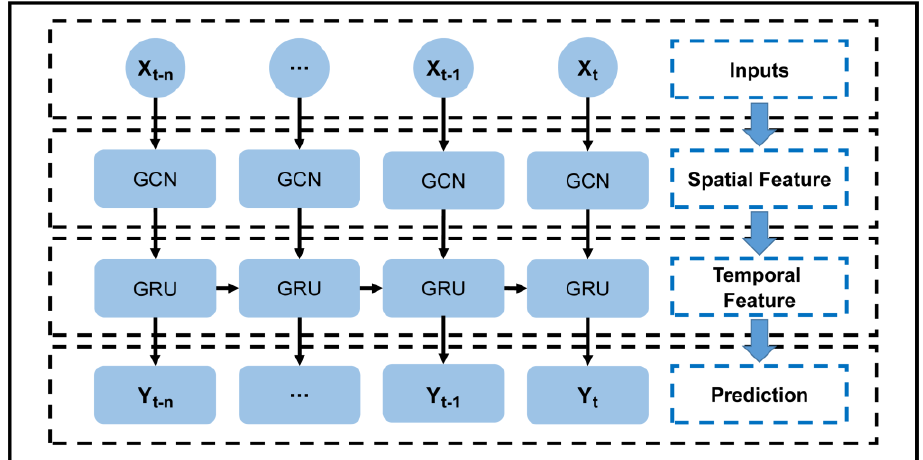
Figure 8. Spatiotemporal graph convolutional network structure [107].